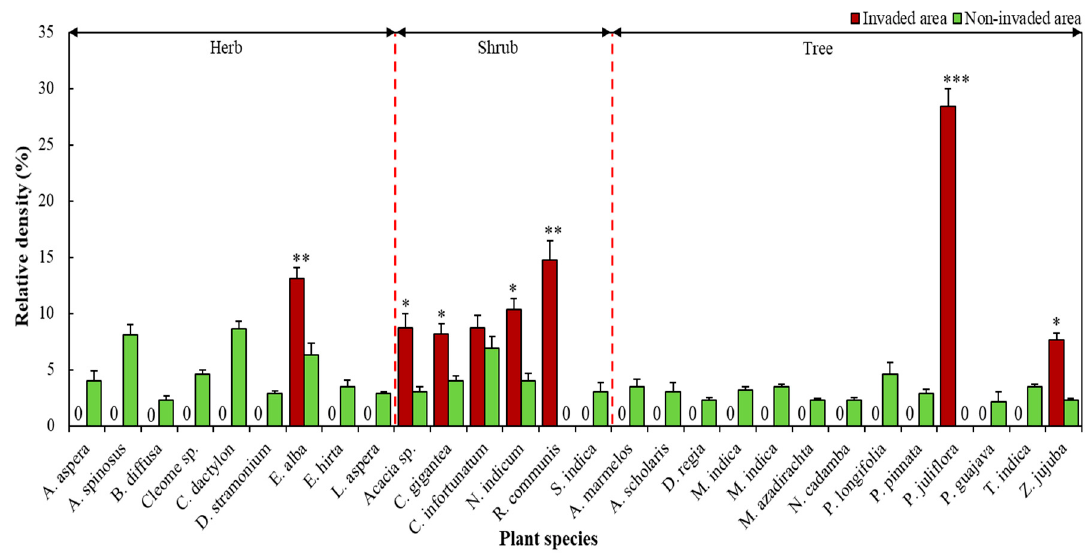
Figure 3. Relative density (RD) of the plant species (herb, shrubs and trees) found in P. juliflora -invaded and non-invaded area of Lucknow, India. Note: The value zero represent the no occurrence of particular species; whereas the asterisk above the bars represents the significance level: * (p < 0.05); ** (p < 0.01). Among the various species, the Cynodon dactylon (L.) Pers. was the most dominant species (with RD of 8.67%) in the non-invaded area followed by Amaranthus spinosus L. (8.09%), Clerodendrum